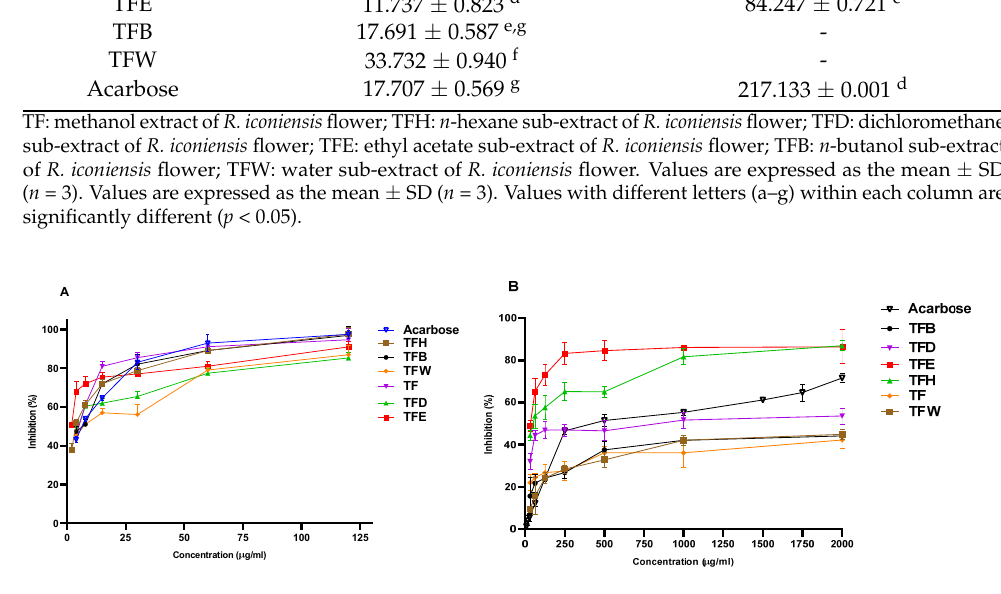
Table 1. α -Glucosidase and α -amylase IC 50 values of the R. iconiensis flower extracts/sub-extracts.